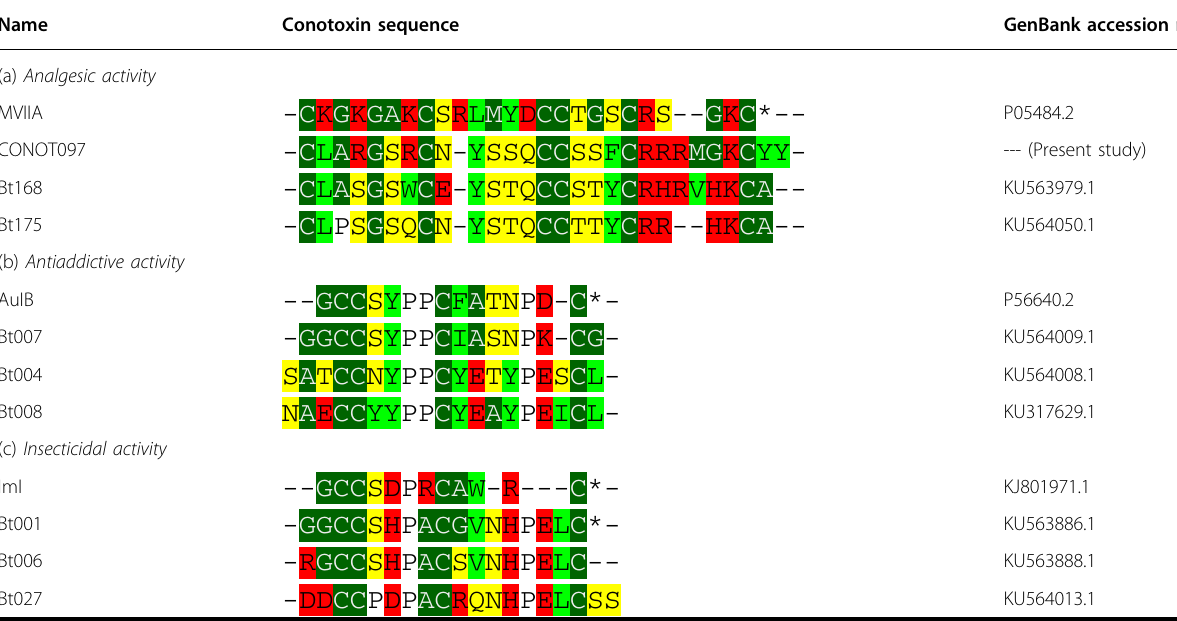
Fig. 5 of Phuong and Mahardika 14 ), which is consistent with the low gene copy number (133) and the proposed primitive status 2 for the vermivorous C. betulinus .